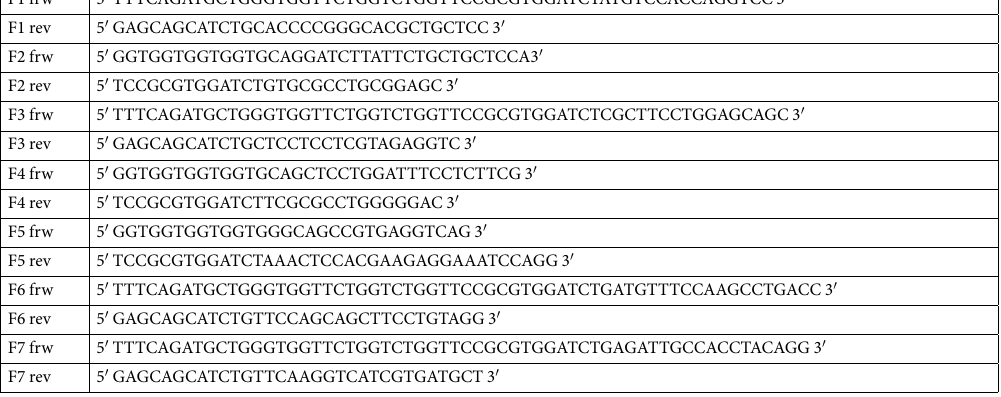
Tabel 1. List of primers used for amplifying fragments of